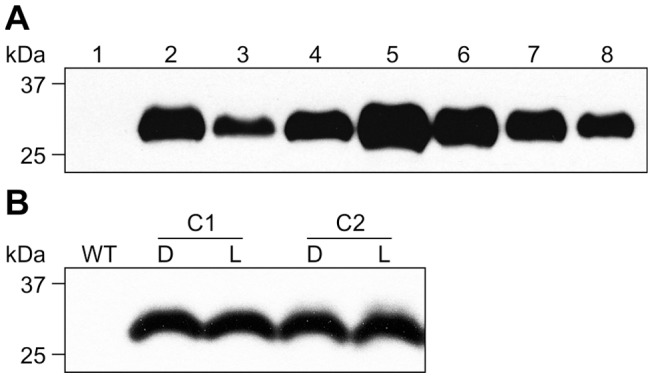
Accumulation levels of rFaeGntd/dsc in transplastomic leaf tissue.(a) Samples of equal volume (4 µl) were prepared from crude extract fractions. Lane 1 - WT extract (negative control); lanes 2, 3 and 4 represent crude extract of 0.4 mg of leaf tissue, re-extracted pellet, and clarified extract, respectively, where clarified extract contains 5 µg TSP. The rFaeGntd/dsc yield was estimated using a standard curve (R2 = 0.993) of known amounts of purified rFaeGntd/dsc (lanes 5 through 8∶2 µg, 1 µg, 0.5 µg and 0.25 µg, respectively). (b) No variation in rFaeGntd/dsc accumulation was observed in transplastomic clones (C1, C2) after dark (D) or after light (L) periods. Image is representative of sampling on three different days, 1 µg TSP was used per lane. WT =  untransformed control.